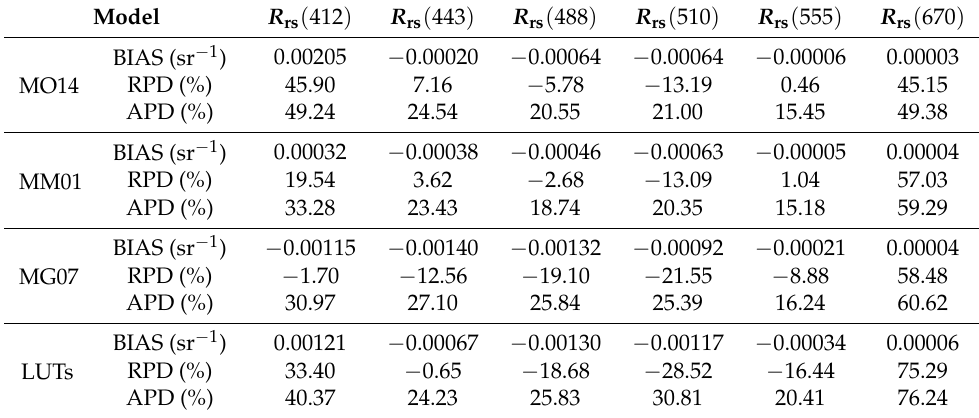
Figure A2. Performance of MM01, MG07, MO14, and LUTs models in open ocean (( a ) MO14, ( b ) MM01, ( c ) MG07, ( d ) LUTs). Table A2. Statistical parameters of MM01, MG07, MO14, and LUTs models in open